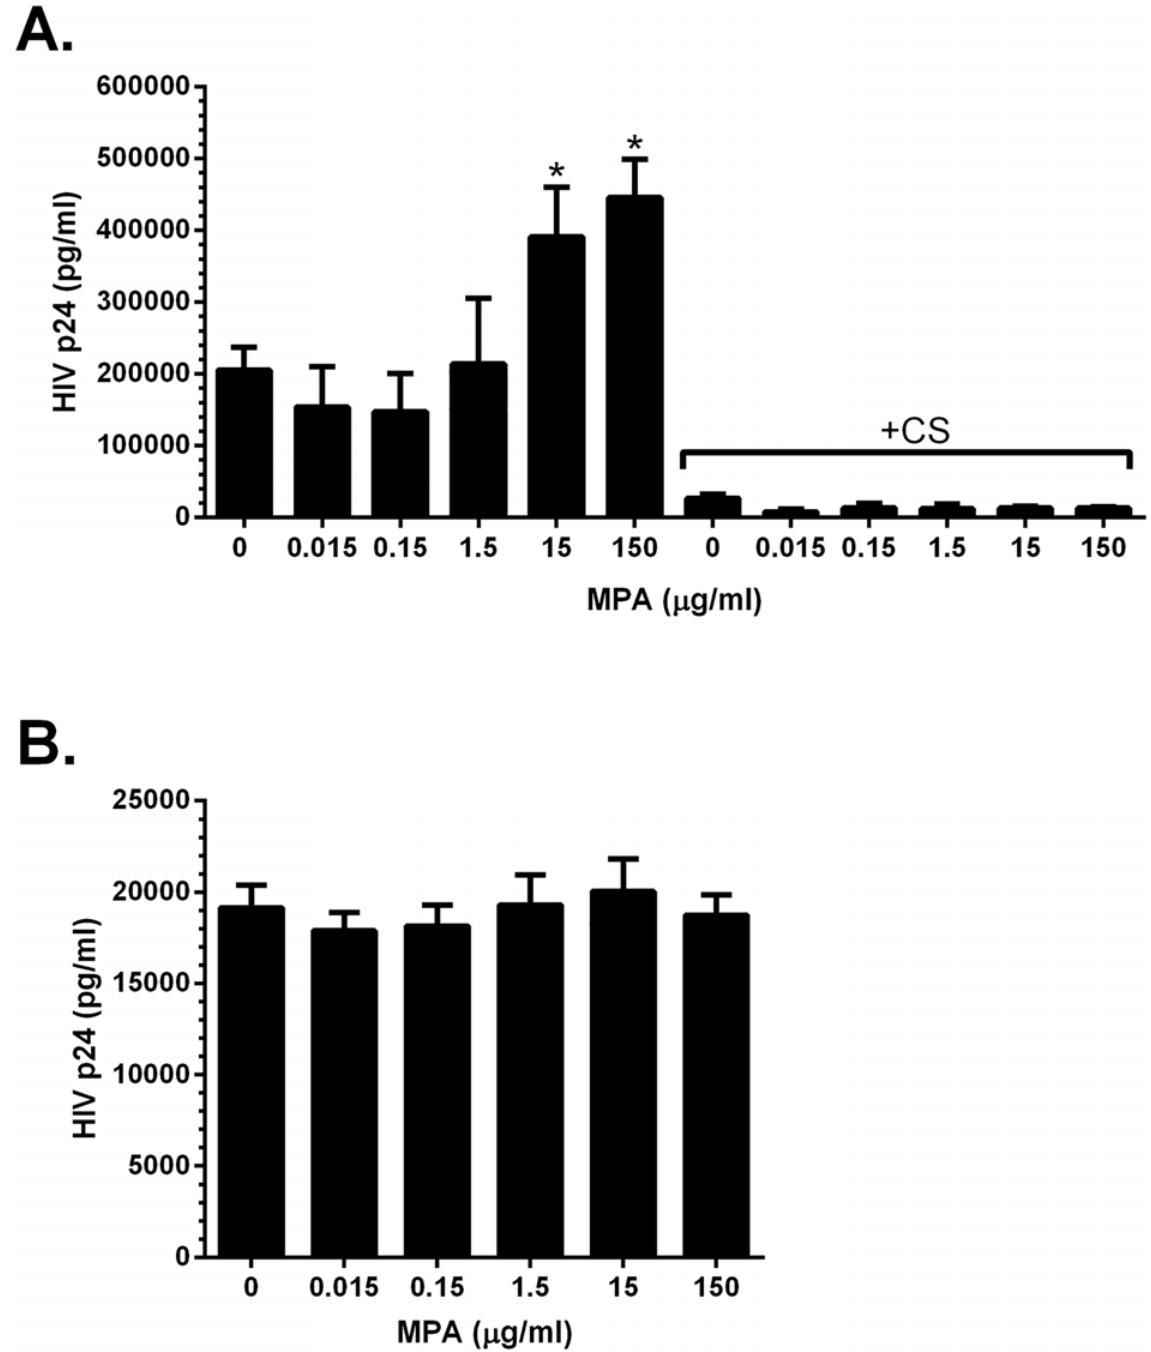
Fig 3. MPA increases HIV in trans infection of T cells. VK2/E6E7 cells were plated in the presence or absence of the indicated concentrations of MPA and 5 days post-plating, were exposed to HIV (80 ng p24) in the presence or absence of cellulose sulfate (100 μ g/ml). One hour post-HIV exposure, the inoculum was removed, cells washed, and the cells were co-cultured with Jurkat-Tat-CCR5 (JT-CCR5) cells for 4 additional hours to allow virus to be transferred from the VK2/E6E7 to the T cells. The JT-CCR5 cells were then removed and cultured for 4 days and the supernatants analyzed for HIV p24 by ELISA (A). Alternatively, the JT-CCR5 cells were plated in the presence or absence of MPA and then directly infected with HIV (0.8 ng p24) and the supernatants analyzed for HIV p24 on day 4 post-infection (B). Results are mean + SEM of at least two independent experiments; asterisks indicate statistically significant differences relative to mock-treated cells, p < 0.05, Student ’ s t-test.